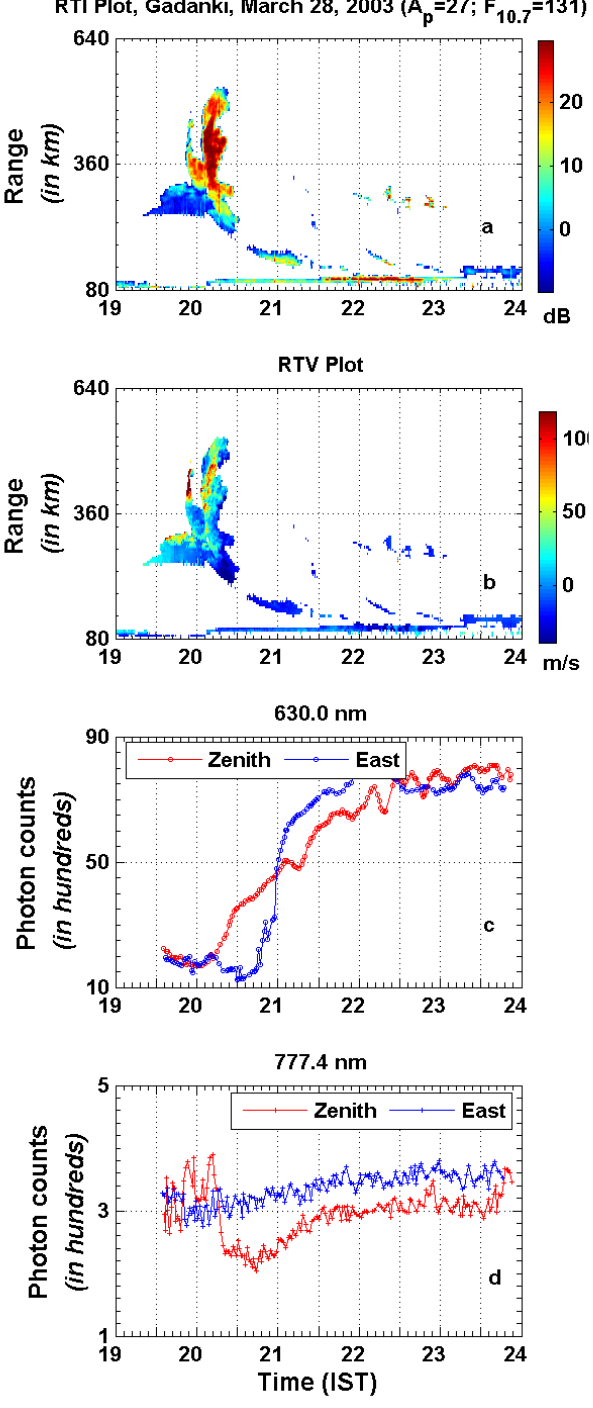
Fig. 6. Similar to Fig. 5 but for 28 March 2003 revealing bottomside ESF structure descending to E-region. Note that the integration time for airglow observations is